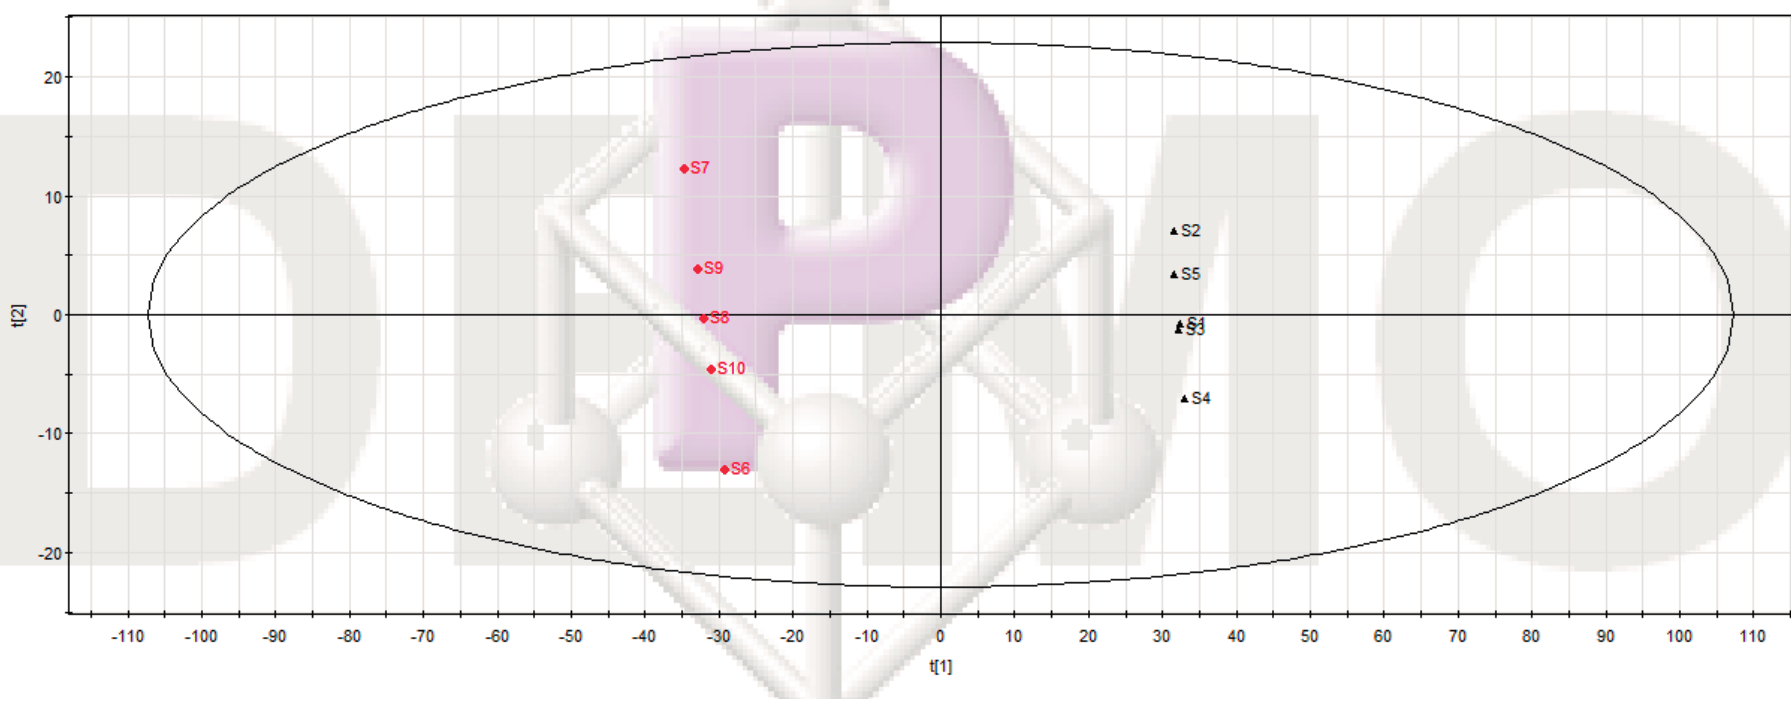
Figure 2. Partial least squares discriminant analysis (PLS-DA) scores plot of Groups 2 and 3. The main composition of the second and the third group of samples could be considered as the composition of burdock leaf fraction before and after inhibiting Pseudomonas aeruginosa biofilm, respectively. Group 2 includes samples 1–5 (S1–S5) and Group 3 includes samples 6–10 (S6–S10). R 2 X = 0.77, R 2 Y = 0.99, Q 2 =